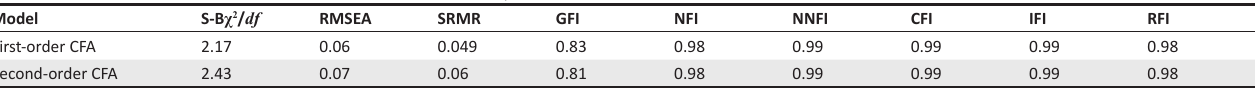
TABLE 3: Goodness-of-fit indices obtained for the Servant Leadership Questionnaire measurement and structural models.